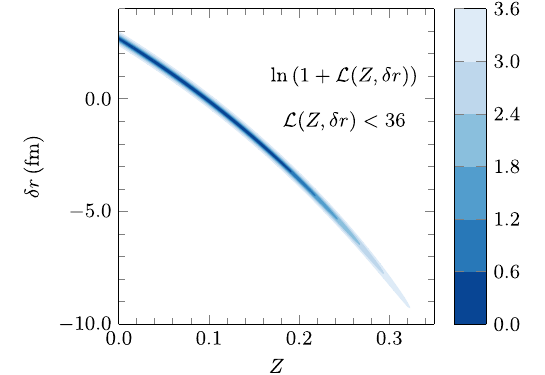
Fig. 3 Compositeness distribution for the 1 S 0 nucleon-nucleon virtual state. Note that the ln ( 1 + L ) function is displayed for L <